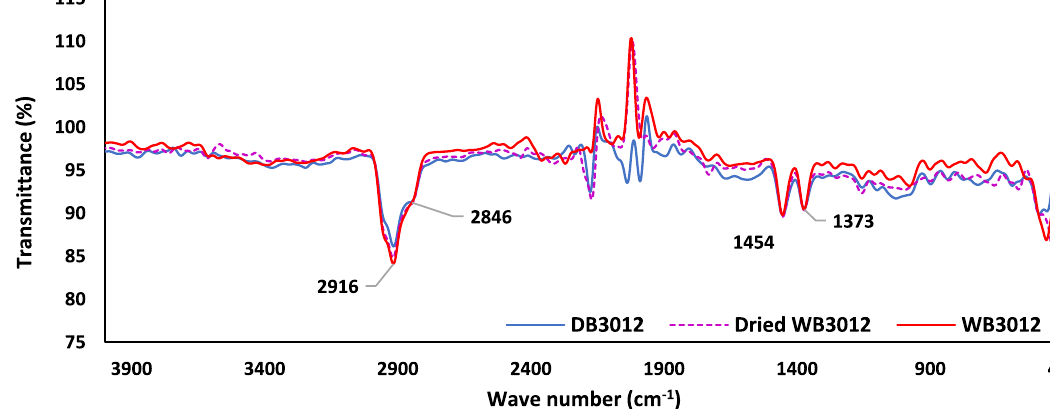
Figure 10. Result of FTIR test for GFRPP specimen.